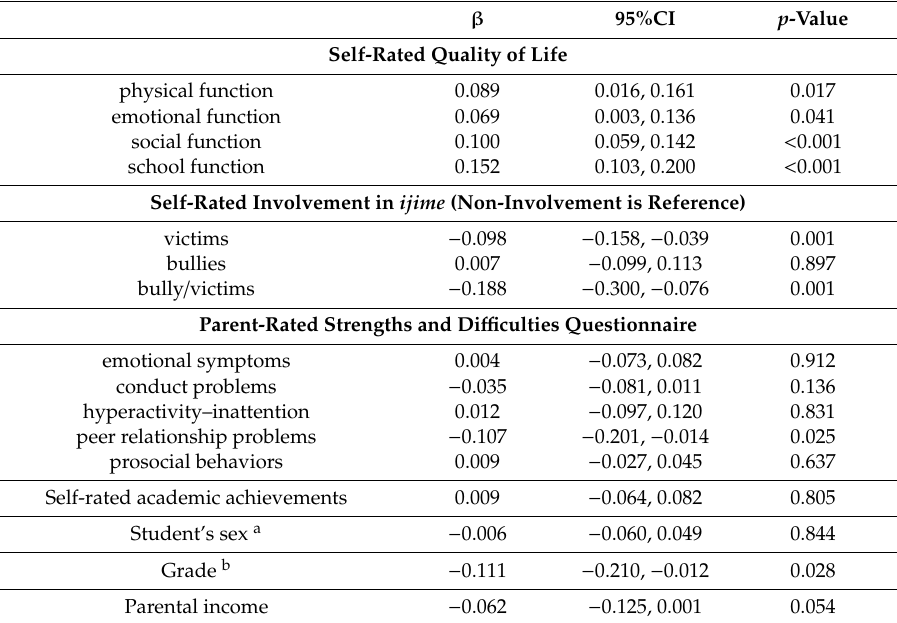
Table 4. Linear regression analysis for the mean score of school